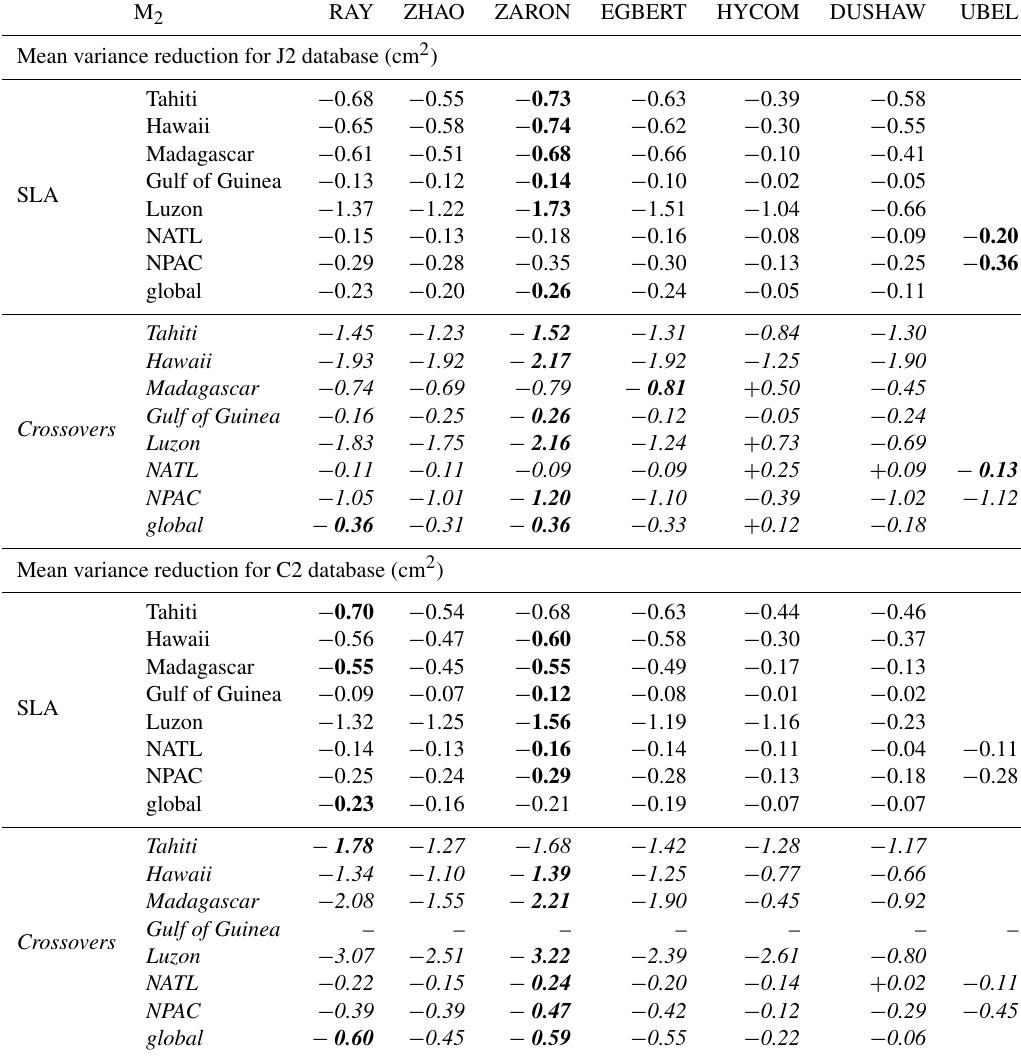
Table 4. Mean variance reduction for the J2 and C2 altimeter databases, within each IT region, when using the different M 2 internal-tide models and compared to the ZERO correction case; variance reduction in altimeter SLA (white lines) and for altimeters crossover differences (italic lines) for each mission, in square centimeters. For each IT region, the maximum variance reduction across the different models is in